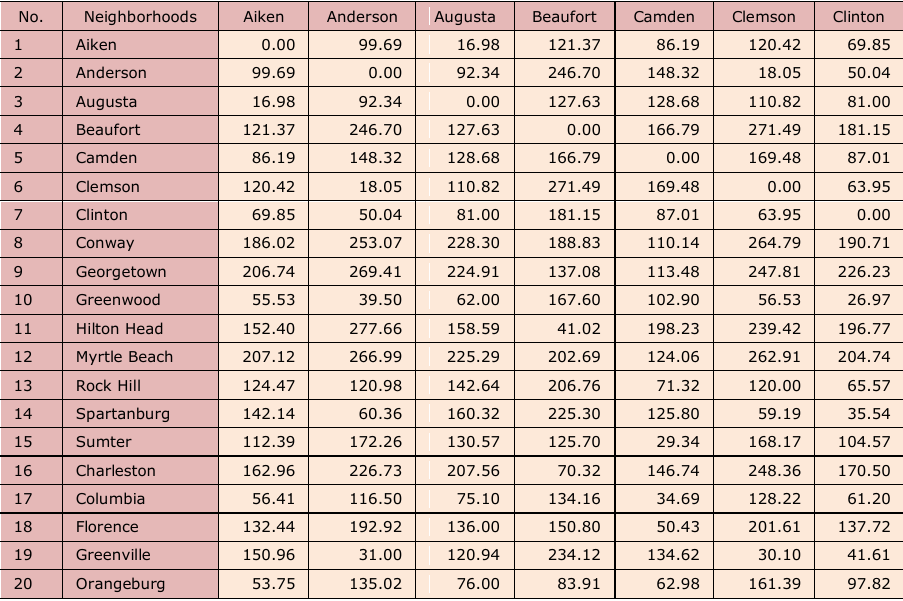
Table 1(a). Distances (in miles) between